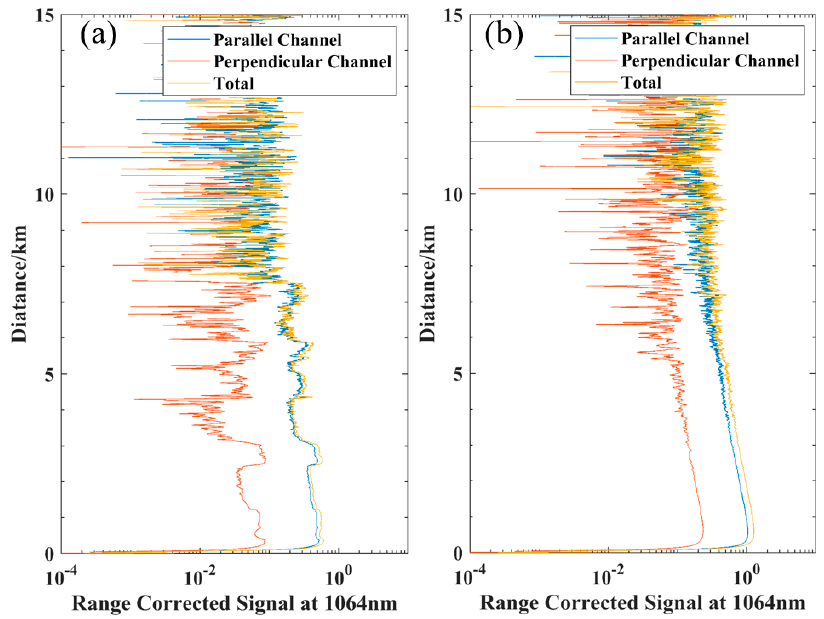
Figure 10. Detection distance test, ( a ) vertical detection and ( b ) horizontal detection.